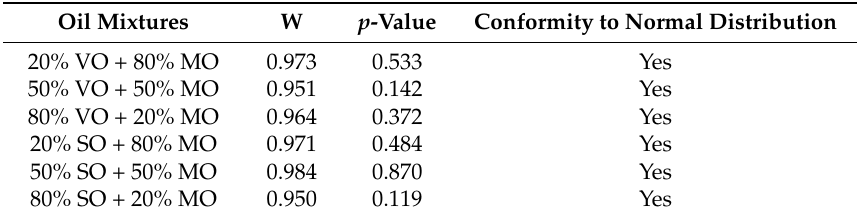
Table 7. Hypothesis test of conformity to normal distribution of oil mixtures in AC.